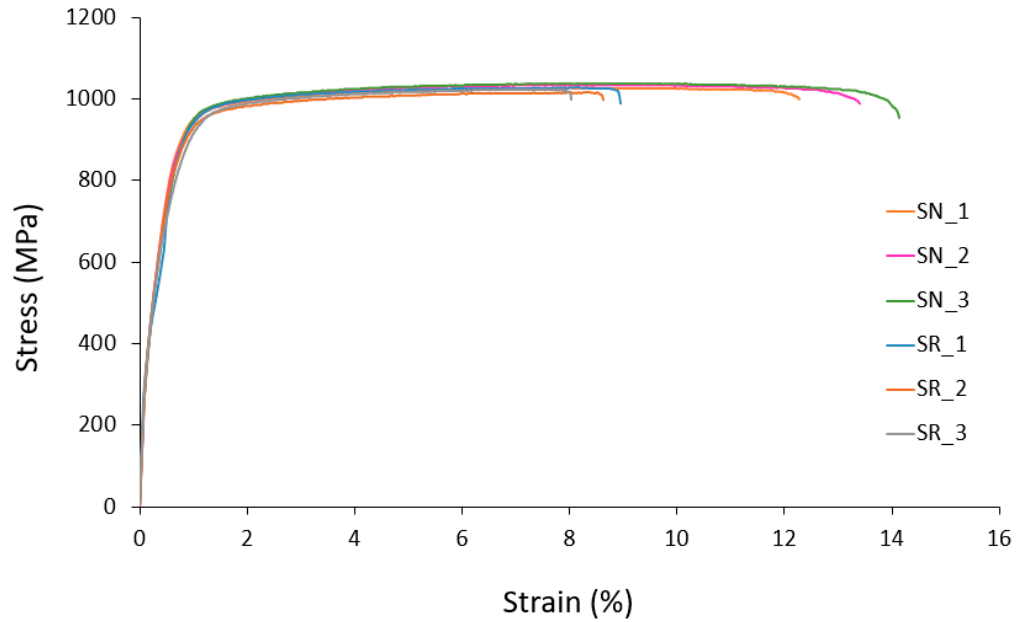
Figure 5. Comparison of tensile test results of 2-mm-diameter LPBF Ti-6Al-4V specimens fabricated with new and recycled powder.